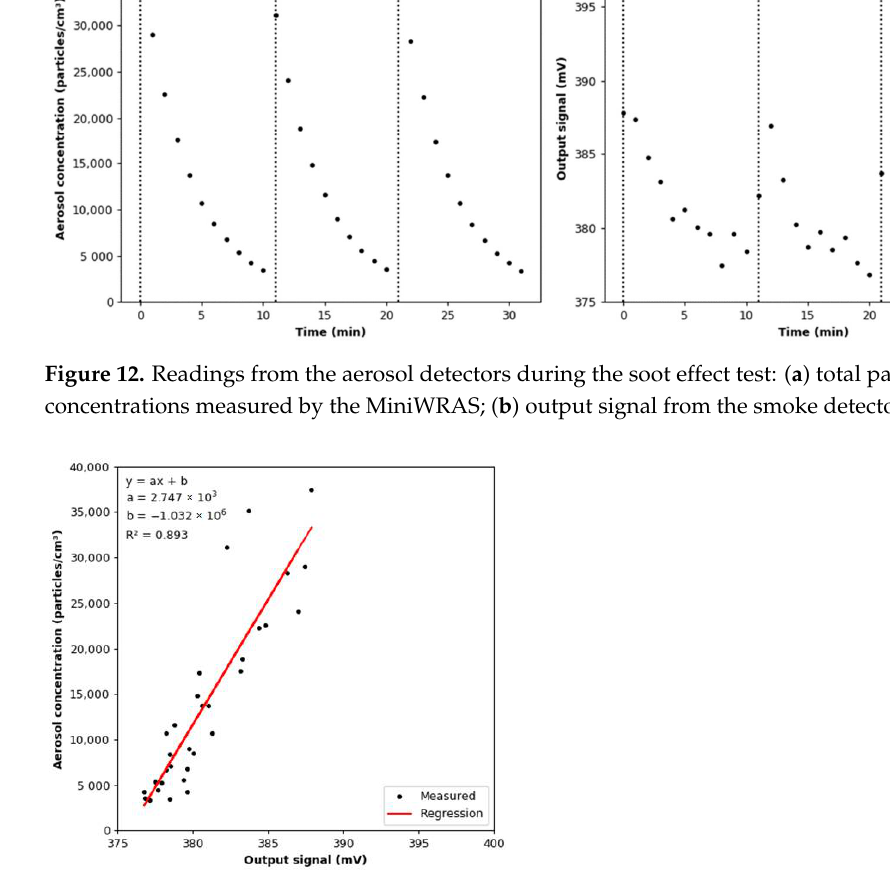
Figure 13. Correlation between the total aerosol concentration and the value of the output signal from the smoke detector under constant humidity conditions. from the smoke detector under constant humidity